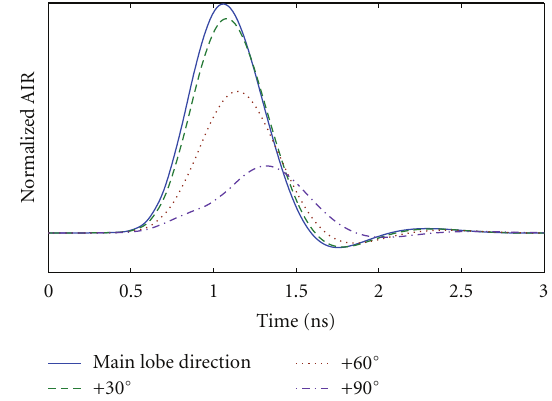
Figure 8: Setup for measuring the signal propagation time between MU and AP with the TDC module. Figure 9: Simulation of the angle-dependent impulse response of the applied AP